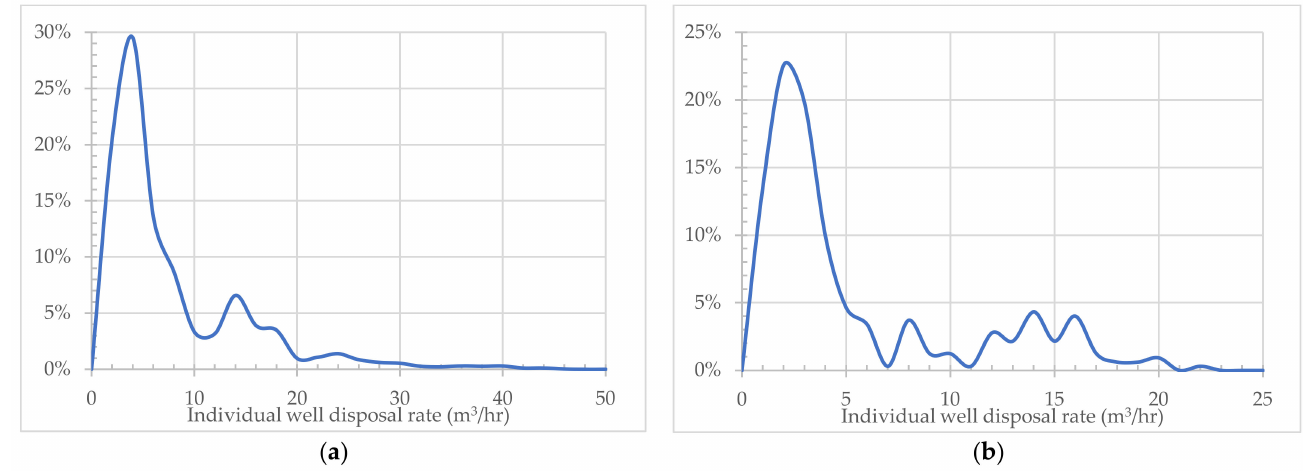
Figure A17. Historical per-well water injection rate ( X -axis) frequency ( Y -axis) distributions (January 1962–December 2022) in ( a ) the Nordegg Formation; ( b ) the Baldonnell Formation.